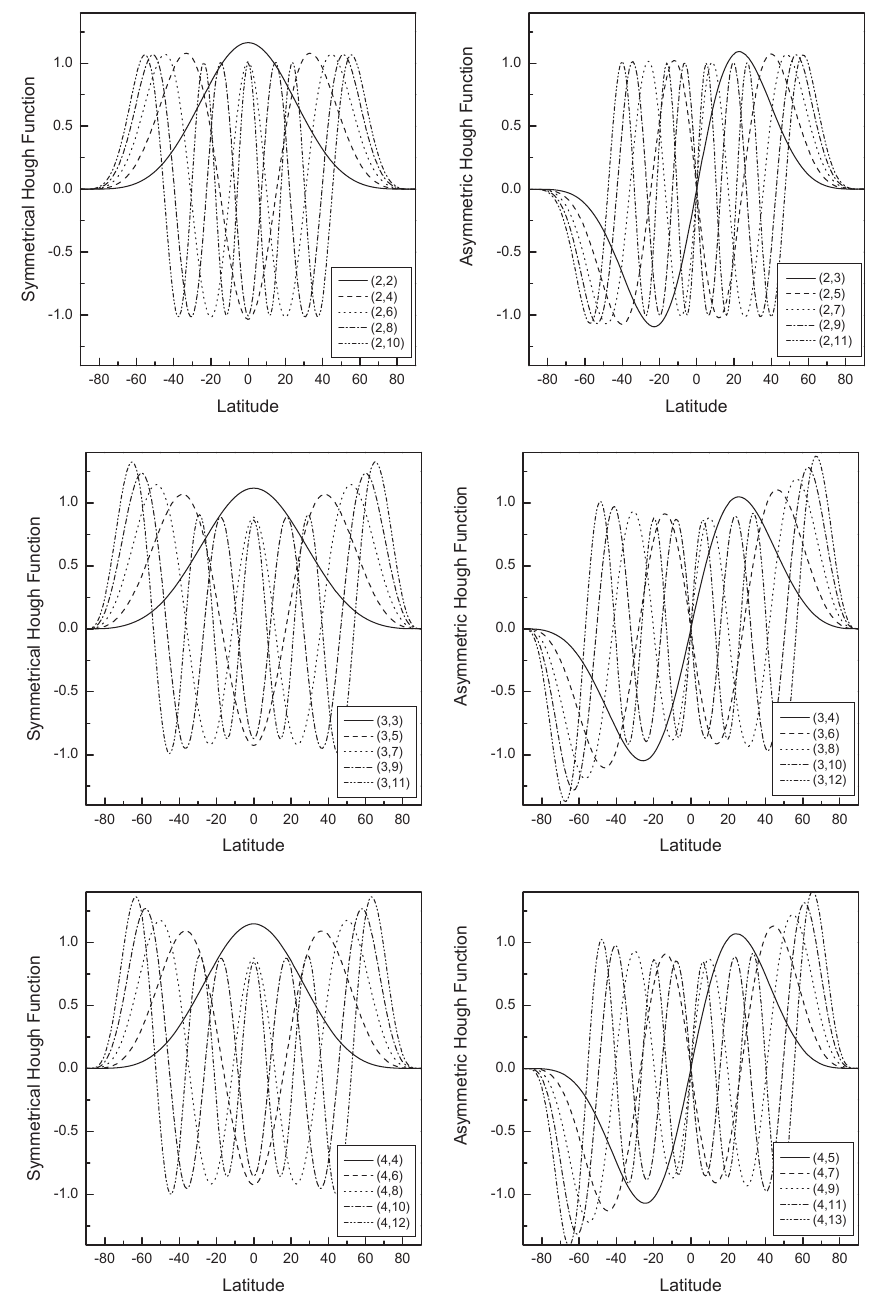
Fig. 2. The first 10 normalized Hough functions for the semidiurnal (upper panel), terdiurnal (middle panel), and 6-h (lower panel) modes. Left panels: symmetric functions; right panels: asymmetric Figure 2 The first 10 normalized Hough functions for semidiurnal mode (upper panel), terdiurnal mode (middle panel), and 6-h mode (lower panel). Left panel: symmetric functions. Right panel: asymmetric functions.